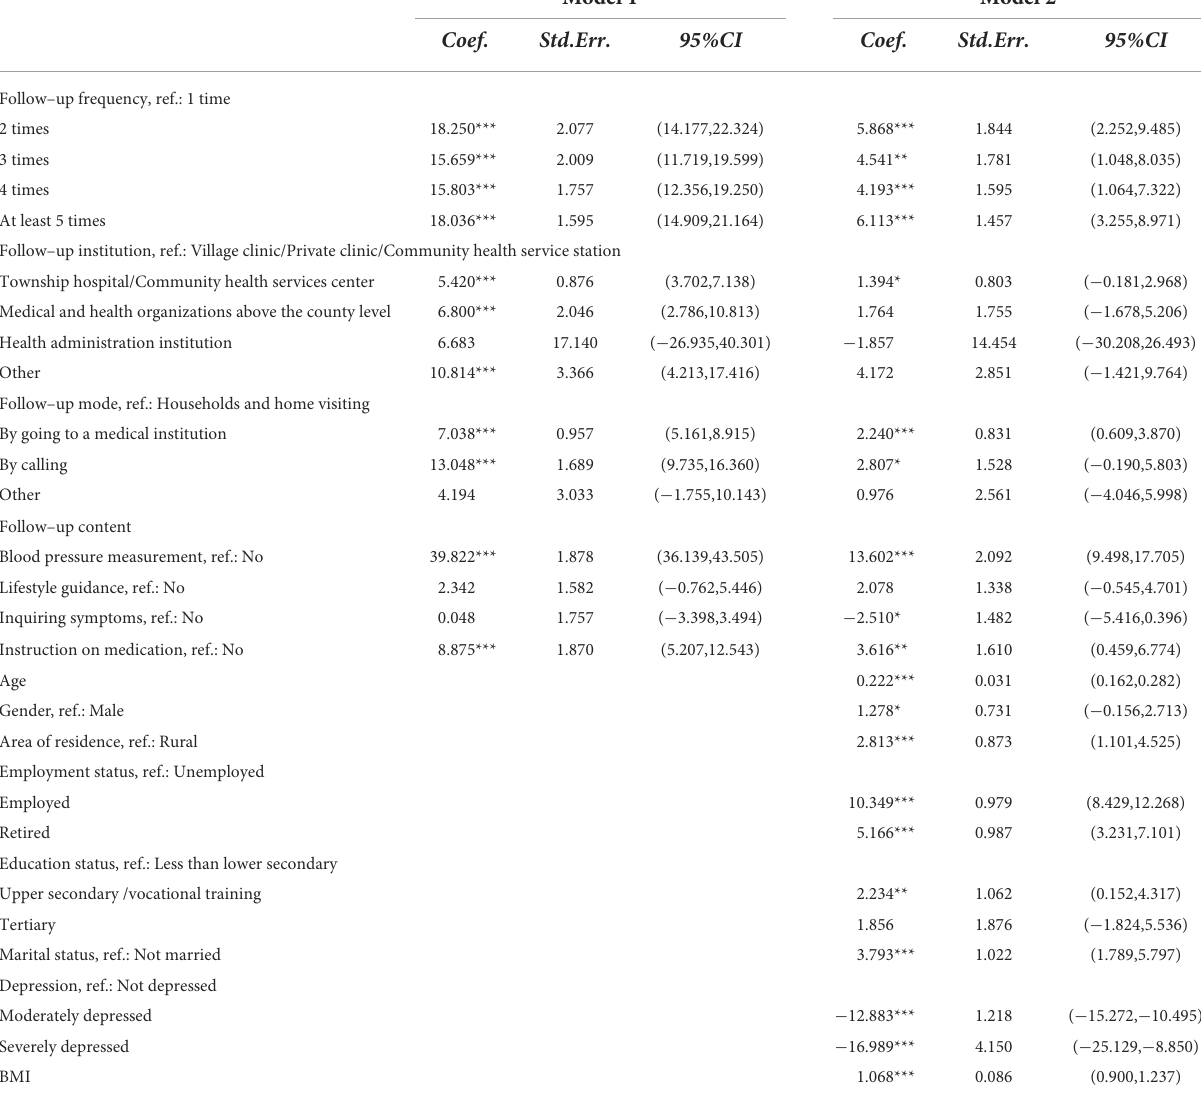
TABLE 4 Linear regression of self-reported health status among hypertensives received follow-up ( n = 1680). Model 1 Model 2 Coef. Std.Err. 95%CI Coef. Std.Err.